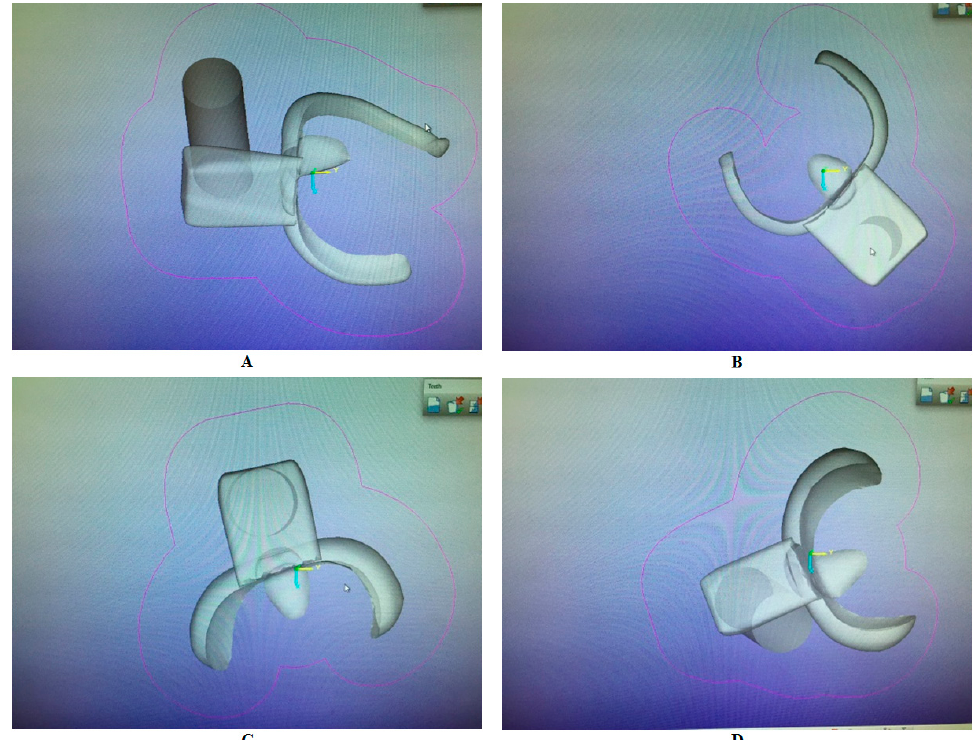
Figure 2 . ( A ) Circumferential clasp design 0.50 (narrow base), ( B ) circumferential clasp design 0.25 (wide base), ( C ) short arm clasp design 0.50 (wide base), and ( D ) short arm clasp design 0.25 (narrow